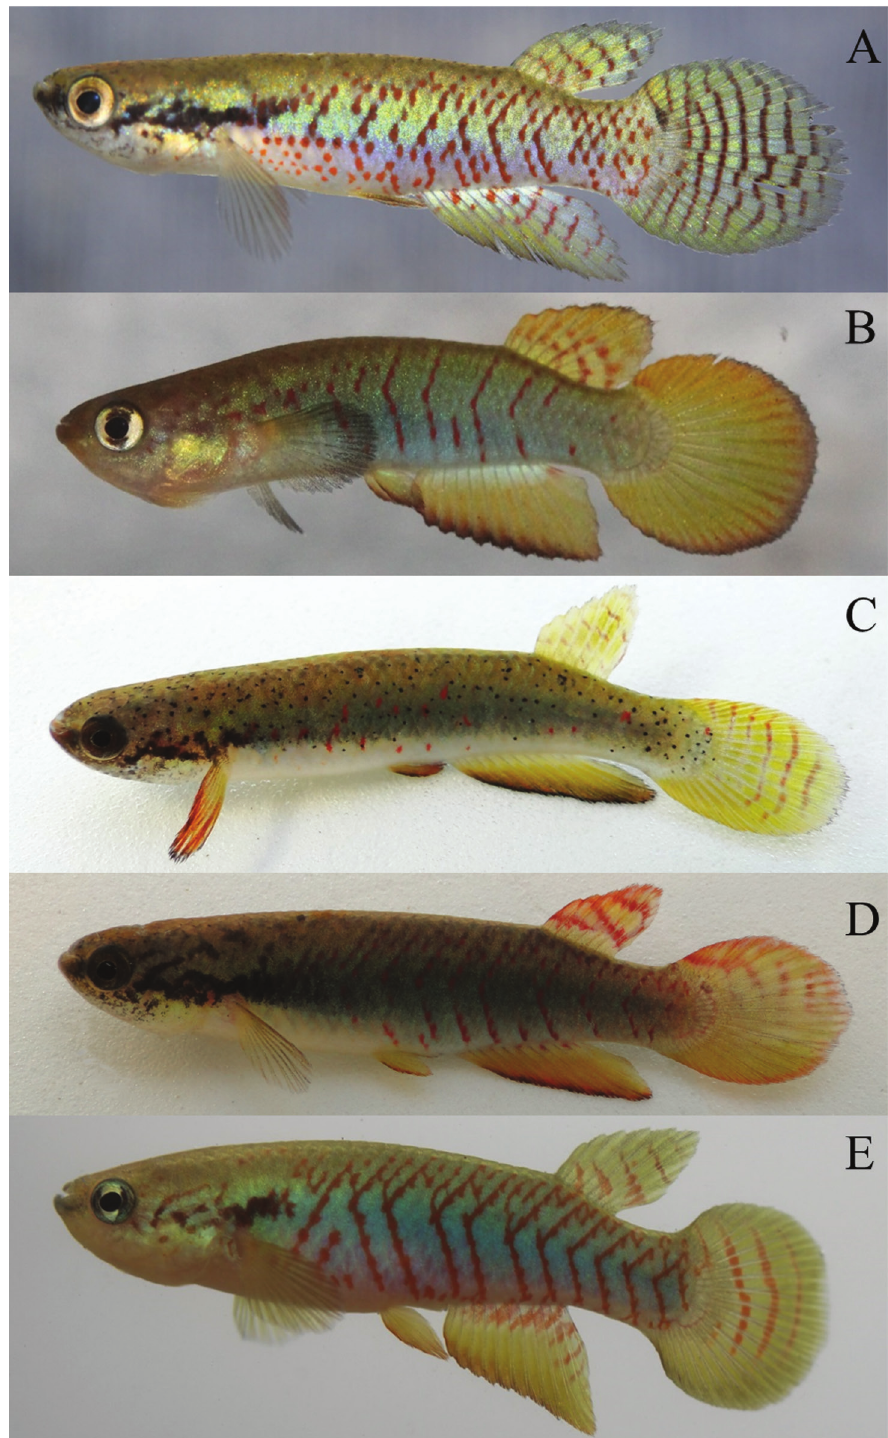
Figure 11. Males of different species of the M. pictus group recorded in the region of the right bank of Rio Paraná. A) M. apiamici ; B) M. egens ; C) M. nigropunctatus ; D) M. ofaie ; E) M. scalaris . Photos by Matheus